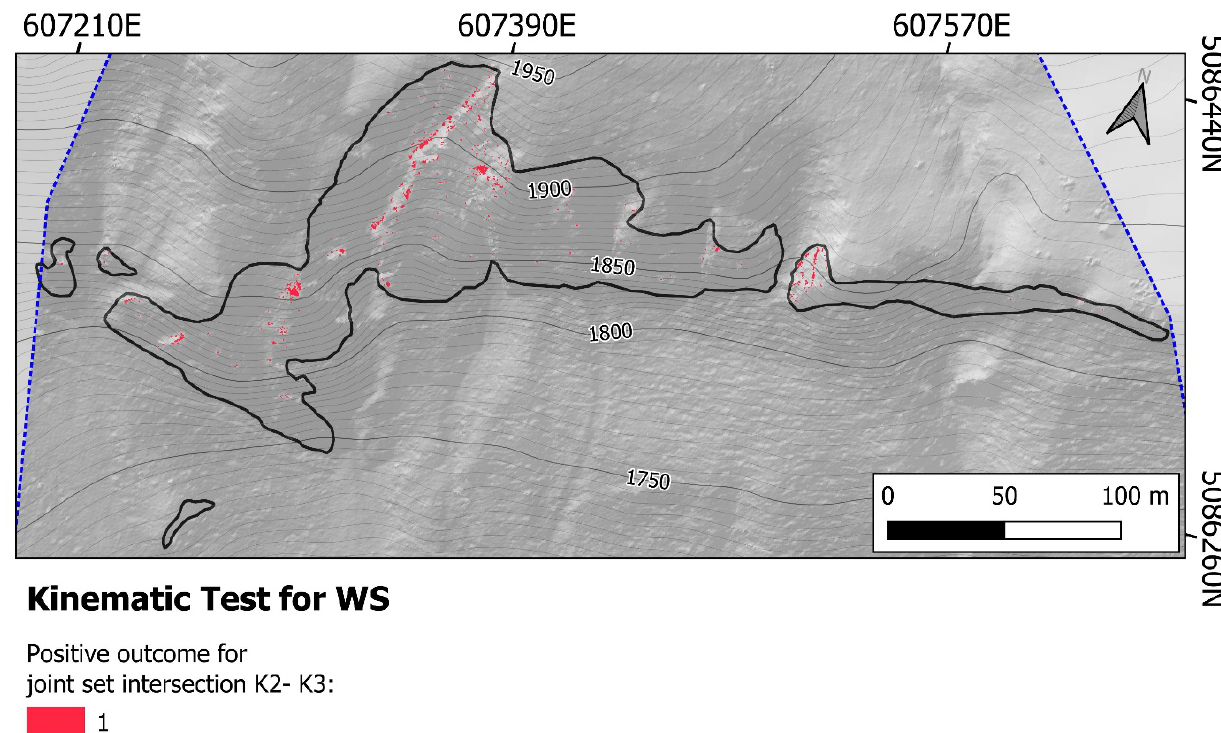
Figure A7. Image of the partial output file showing the kinematic test for WS performed considering only the intersection between joint set K1 and K4, which always tested negative.